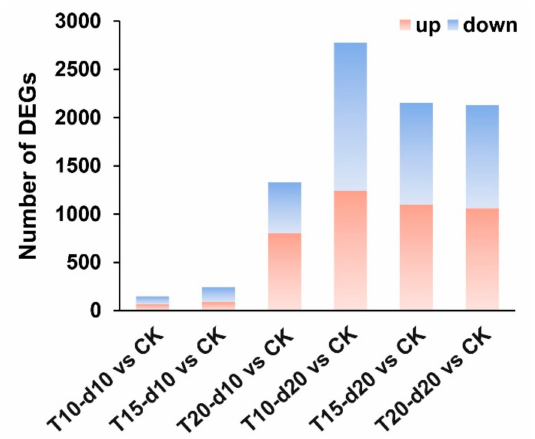
Figure 2. Stat chart of di ff erentially expressed genes (DEGs) in di ff erent treatments. Distribution of DEGs on di ff erent days at di ff erent overnight temperatures. The DEGs were identified with the criteria (log2 (Ratio) ≥ 1 and p < 0.05).